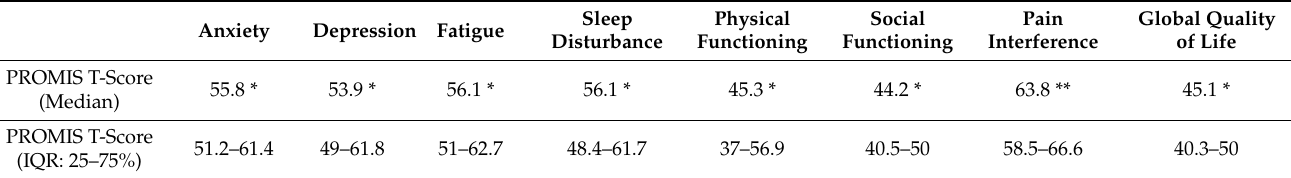
Table 2. Quality of life in patients presenting to the specialised headache outpatient clinic. Headache patients were self-administered an assessment of quality of life (QoL) through these patients reported outcome measurement information system profile with 29 items (PROMIS-29), which provides a disease independent estimate of 7 domains of and global QoL. By definition, the population mean is a T-score of 50 and standard deviations are standardised to a T-score of 10 (e.g., a T-score of 70 indicates two standard deviations above population mean). Median T-scores of the headache population were tested for statistical difference against a T-score of 50, i.e., whether headache patients score significantly worse or better than the mean population. Pain interference was also tested against a T-score of 60. We found that headache patients perform significantly worse in all PROMIS domains and that particularly pain interferes with their QoL. */** = difference statistically significant against a T-score of 50 or